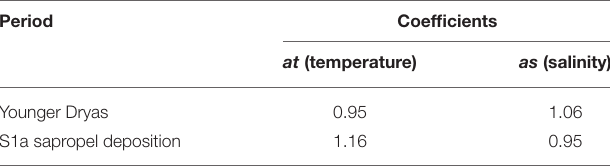
TABLE 1 | Values of the correction coefficients applied to the reference model to reach extreme case sea surface conditions similar to paleoceanographic